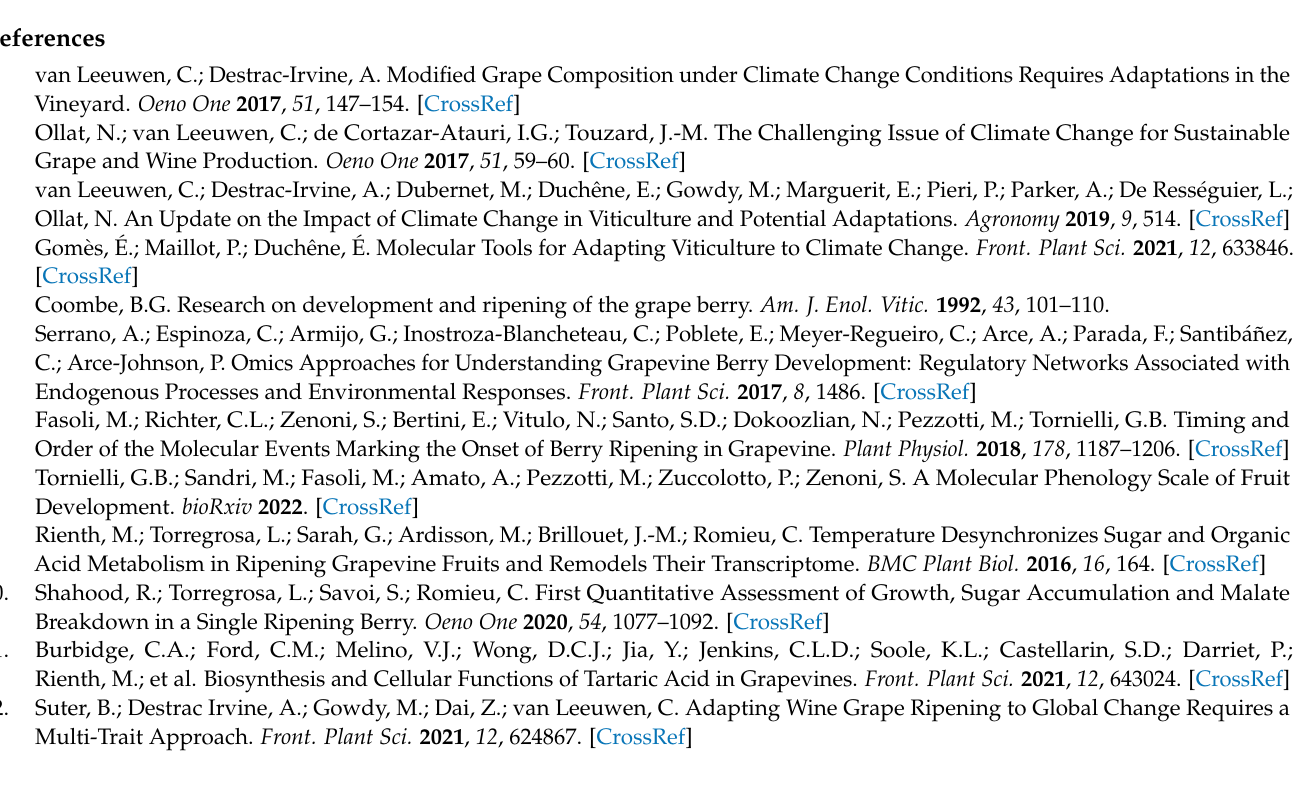
Table S2: Gene Set Analysis Results; Table S3: Genes DEGs in Berries relate to the cell wall metabolism of BS grape clusters; Table S4: Categories and genes used for GSA analysis; Table S5: List of primer used for